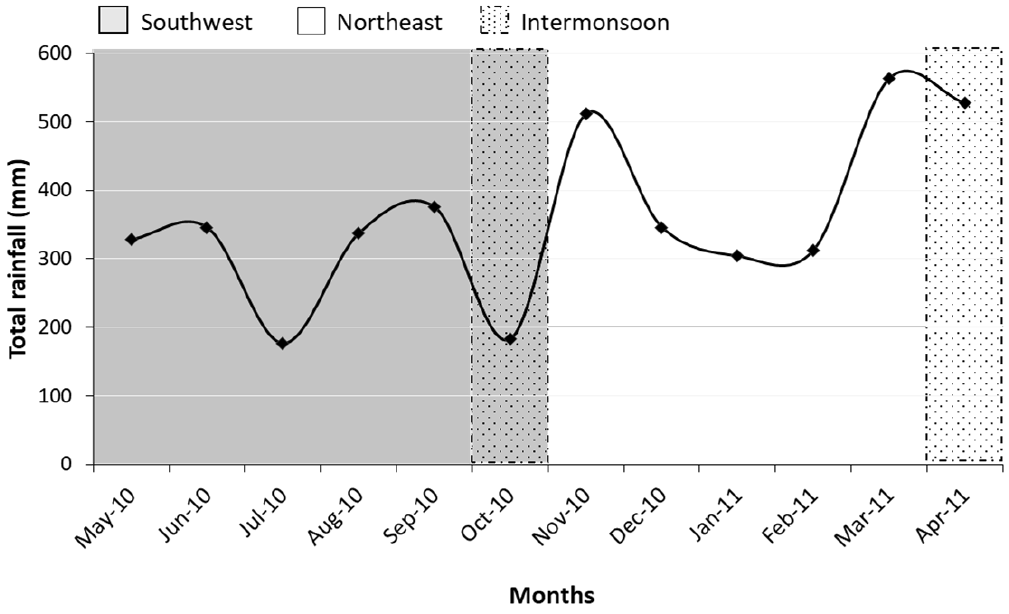
Figure 3. Rainfall data of the study area showing the dry season during the southwest monsoon (May to September) and wet season during the northeast monsoon (November to March) separated by inter-monsoons in October and April.